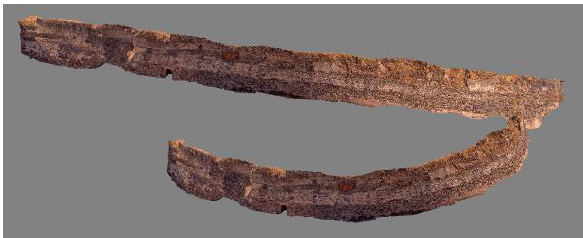
Figure 8. Curved surface (bottom) and unrolled surface (top).